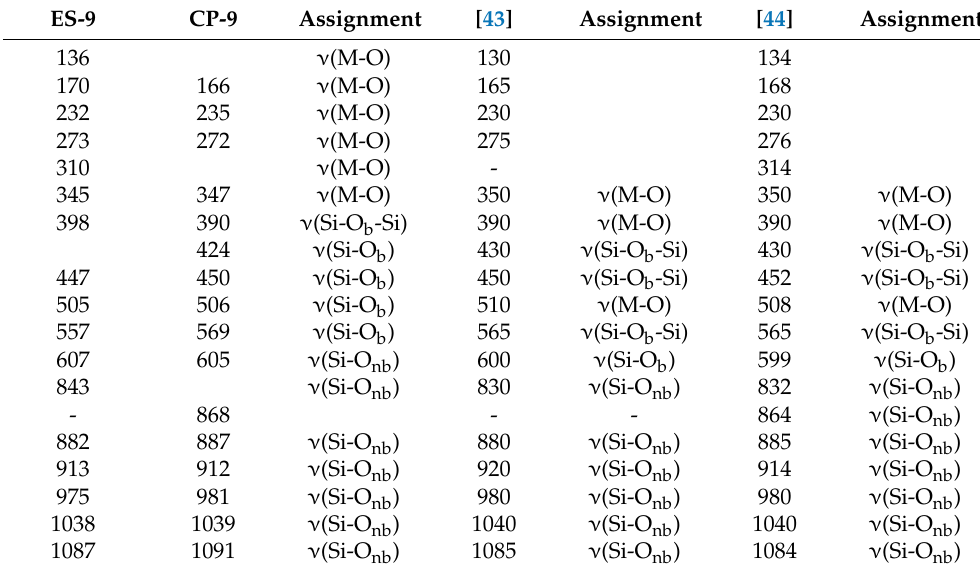
Table 7. Assignment of epidote and clinozoisite bands in the Raman spectra of studied samples.